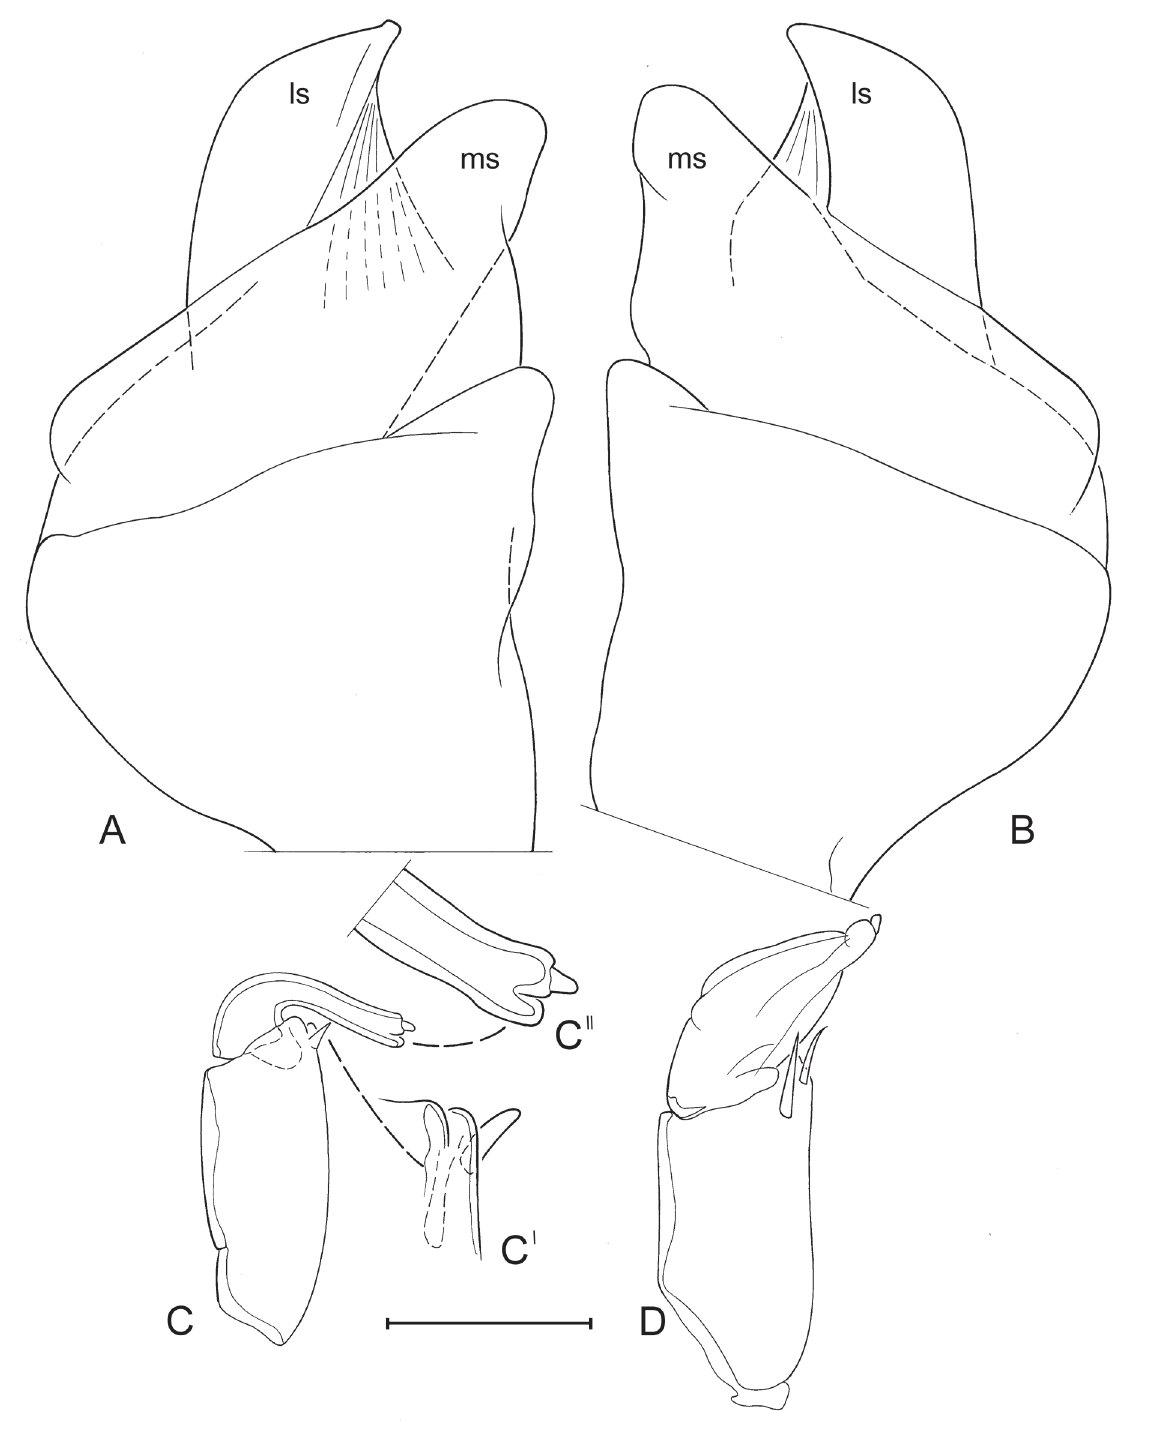
Fig. 10. Bennelongia timmsi sp. nov., male paratype (WaMc52232) from type locality (Wave rock, BVt/10/05) aberrant specimen. A . Hemipenis. B . Hemipenis. C . left prehensile palp. C’ . Idem, detail of ventroapical part of first segment, showing two lobes and a sensory organ. C” . Idem, detail of distal part of second segment, showing aberrant, bilobed morphology. D . right prehensile palp. scale: a-D = 92 µm; c’, c” = 37